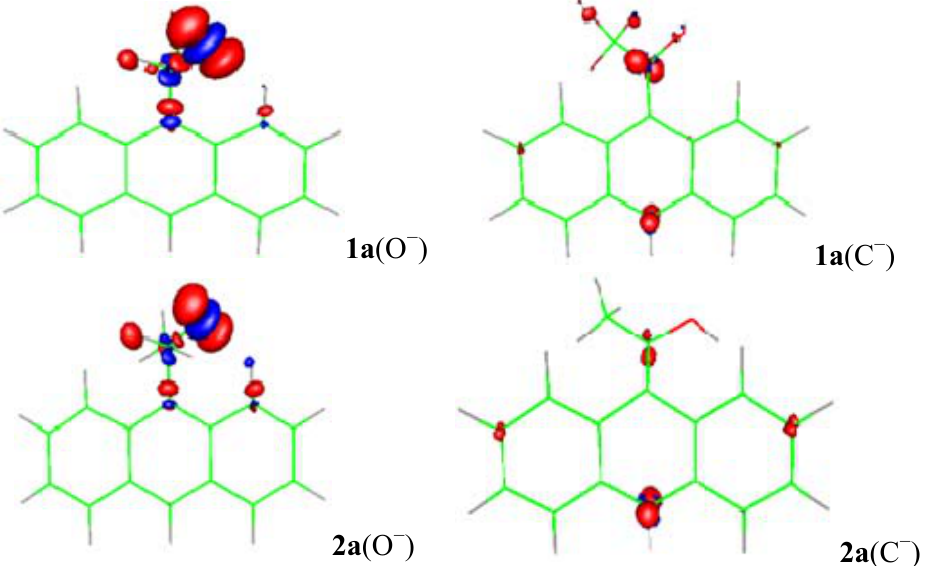
Figure 2. The surface plot of the electrophilic Fukui function for the alkoxides (O − ) and carbanions (C − ) of 1a and 2a .